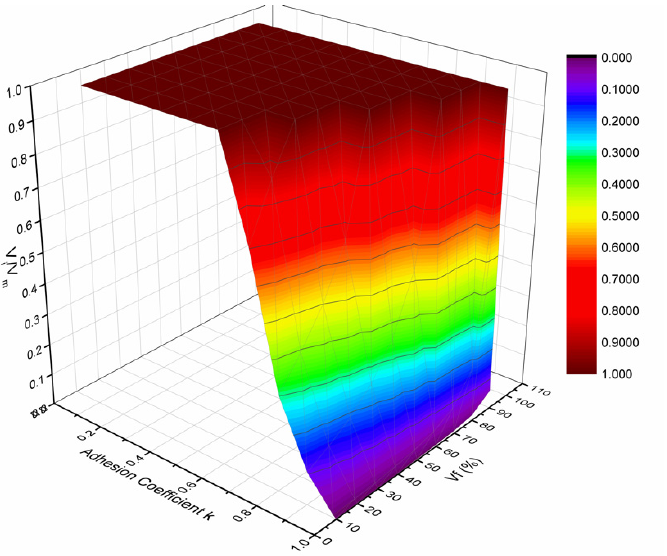
Figure 8. Three-Dimensional diagram showing the variation of the relative interphase volume fraction V i /V m versus the adhesion coefficient k E and the fiber volume fraction, V f .